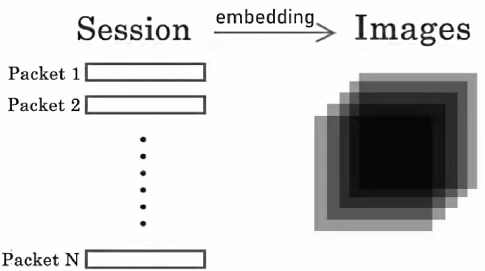
Figure 2. Transform a session into a batch of images. The number of images M is calculated by: [( N − 1 ) /54 ] + 1.